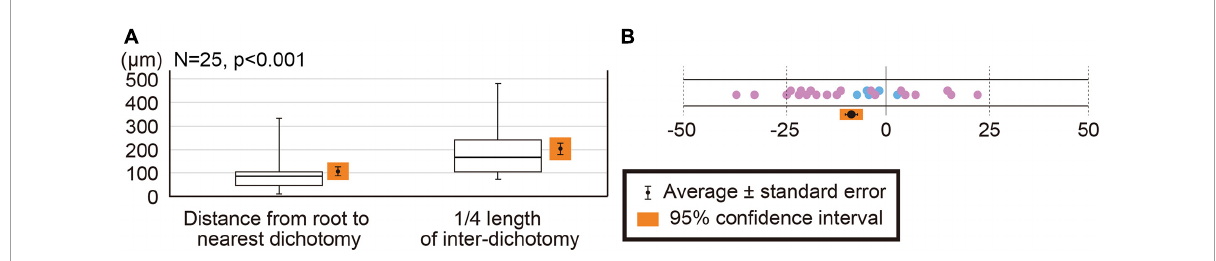
FIGURE7 Comparison of root-dichotomy distances to quarter lengths of inter-dichotomies. (A) Box-whisker plots showing root-dichotomy distances and quarter lengths of inter-dichotomies. Bold lines show medians. (B) Relative root-dichotomy distances. Positions of dichotomies are set to zero, while lengths of inter-dichotomies to 100. Negative values indicate that the root primordium formed apical to a dichotomy. Root primordia associated with the first dichotomy are indicated by blue circles, while those with the second one by